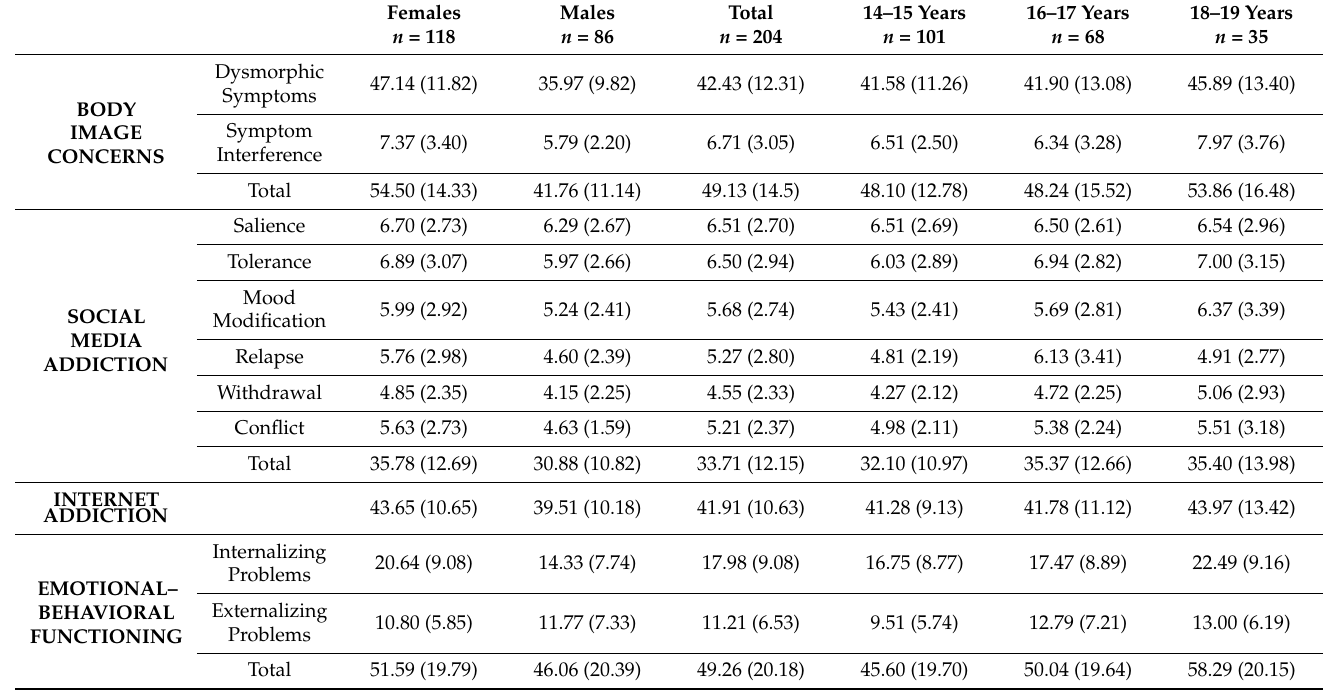
Table 1. Descriptive statistics (mean and standard deviation) for the variables of